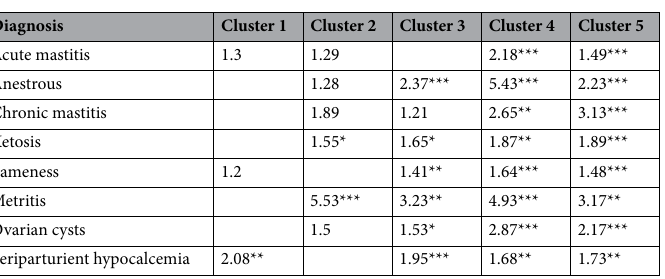
Table 1. Odds ratio (OR) of the individual farm risk profiles. Empty fields indicate cluster with the lowest disease prevalence.